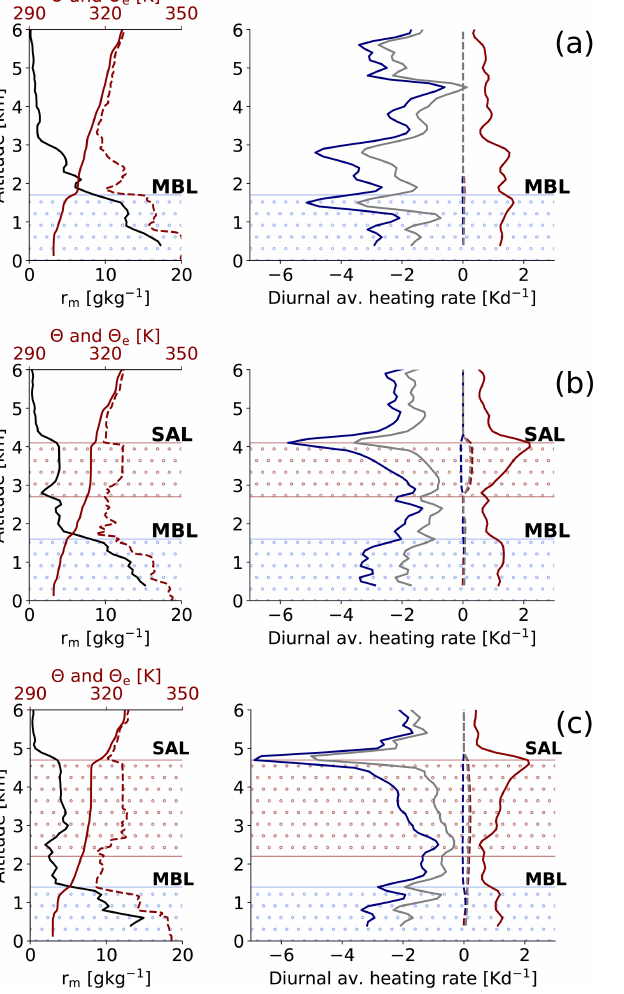
Figure 4. Left: the vertical profiles of derived water vapor mass mixing ratio from DIAL measurements (black), potential tempera- ture (cid:50) (solid red) and equivalent potential temperature (cid:50) e (dashed red) from dropsonde measurements for the three scenarios (a) , (b) and (c) . Right: the diurnally averaged net (grey), short-wave (red) and long-wave (blue) heating rates (solid) for cases (a) , (b) and (c) . Dashed lines illustrate the aerosol-contributions to the total heating rate profiles. Colored height intervals highlight the approximate ex- tent of observed Saharan air layers (SAL; dotted red) and marine boundary layers (MBL; dotted